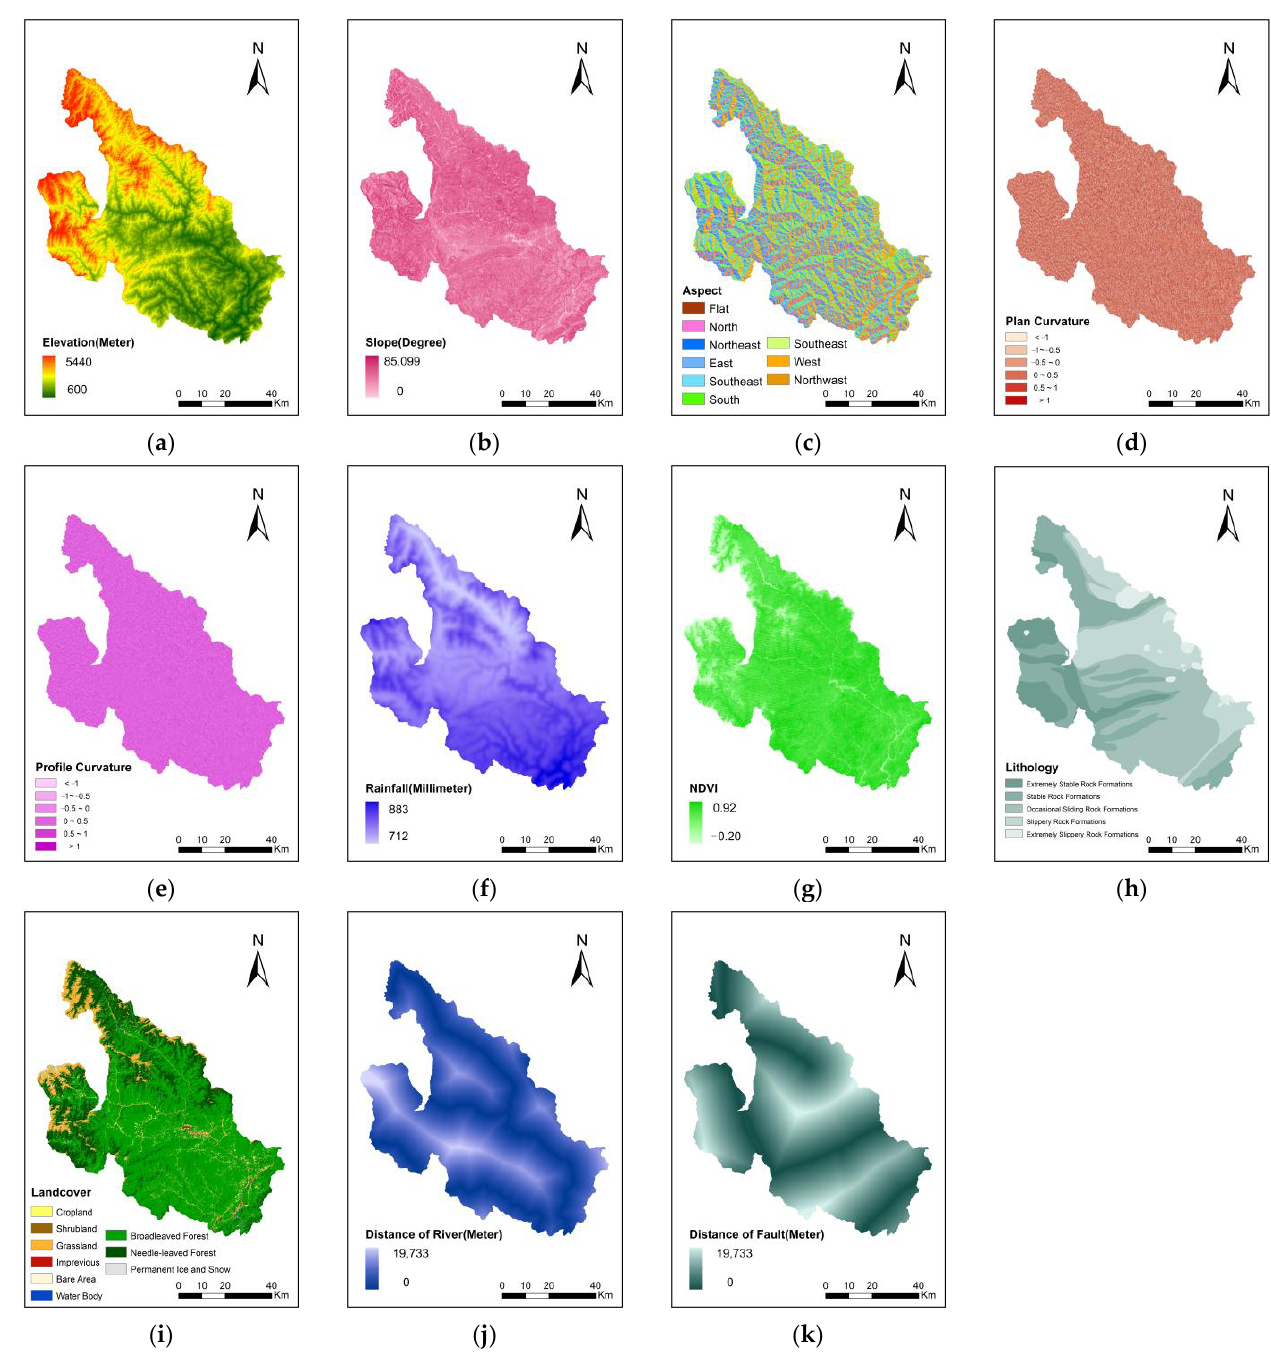
Figure 2. Landslide conditioning factors of LSM; ( a ) Elevation, ( b ) Slope, ( c ) Aspect, ( d ) Plan curvature, ( e ) Profile curvature, ( f ) Rainfall, ( g ) NDVI, ( h ) Lithology, ( i ) Landcover, ( j ) Distance to river and ( k ) Distance to fault.